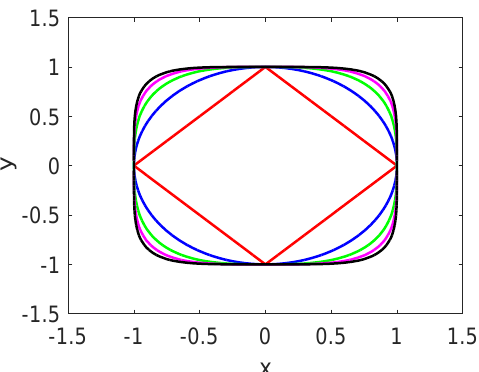
Figure 1. Different shapes of equilibrium points of system (3), k = 1,2,3,4,5, from the interior to the outside,